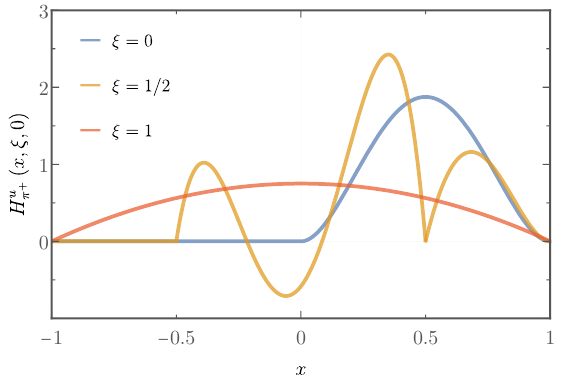
Figure 2: Pion GPD model obtained from the covariant extension of the algebraic model DGLAP-GPD yielded by the parametrisation of the pion-PDF given in Eq. [ 3 ]